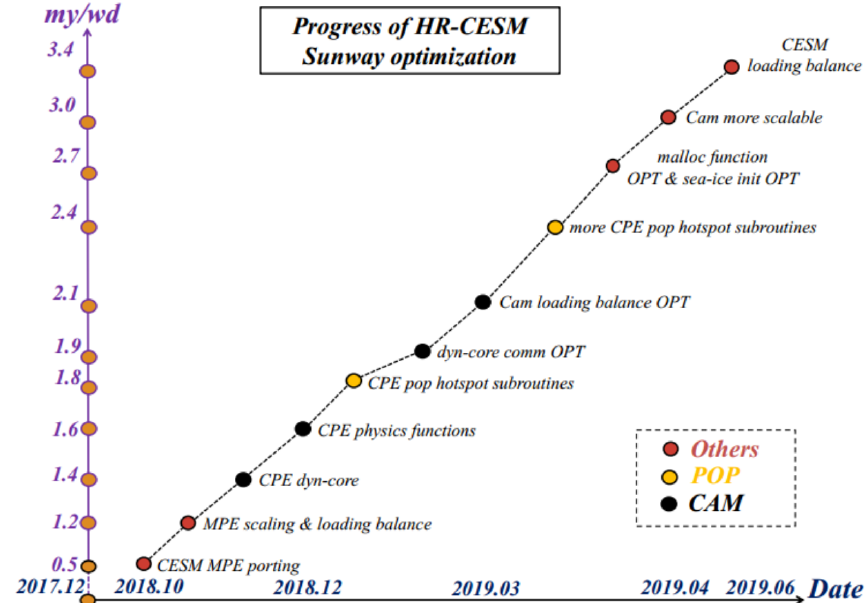
Figure 11. The schedule of CESM-HR optimization on the Sunway TaihuLight.